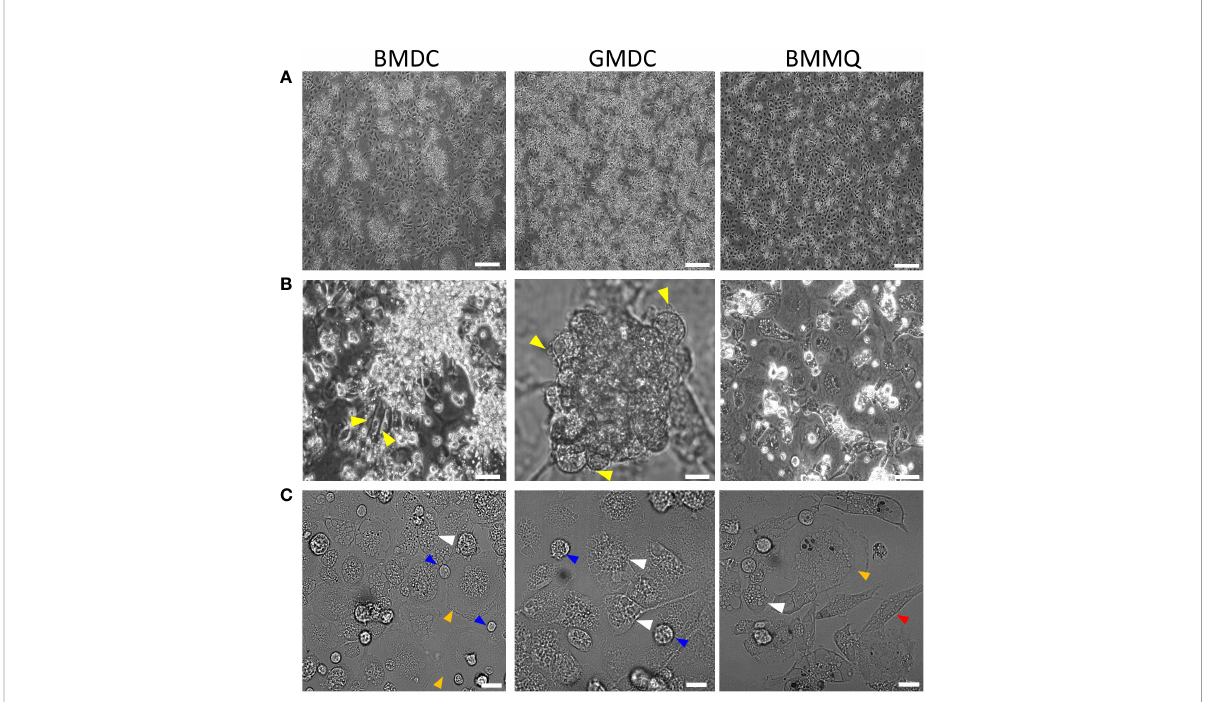
FIGURE 1 CSF1 induces a morphologically homogenous BM cell cultures in contrast to BM treated with CSF2 + IL-4 or CSF2 alone. (A) Representative DIC images of chicken BM cells treated with CSF2 + IL-4 (BMDC), CSF2 (GMDC) or CSF1 (BMM F ) on day 4 of culture. (B) Yellow triangles indicate veiled cells (C) white triangles indicate cells with numerous intracellular vacuoles, blue triangles shows small round cells and orange triangles show large cells and red triangles show elongated cells. Images of three independent BM cultures derived from 5-week-old chickens. Scale bar represents 100 µm in A and 50 µm in B and